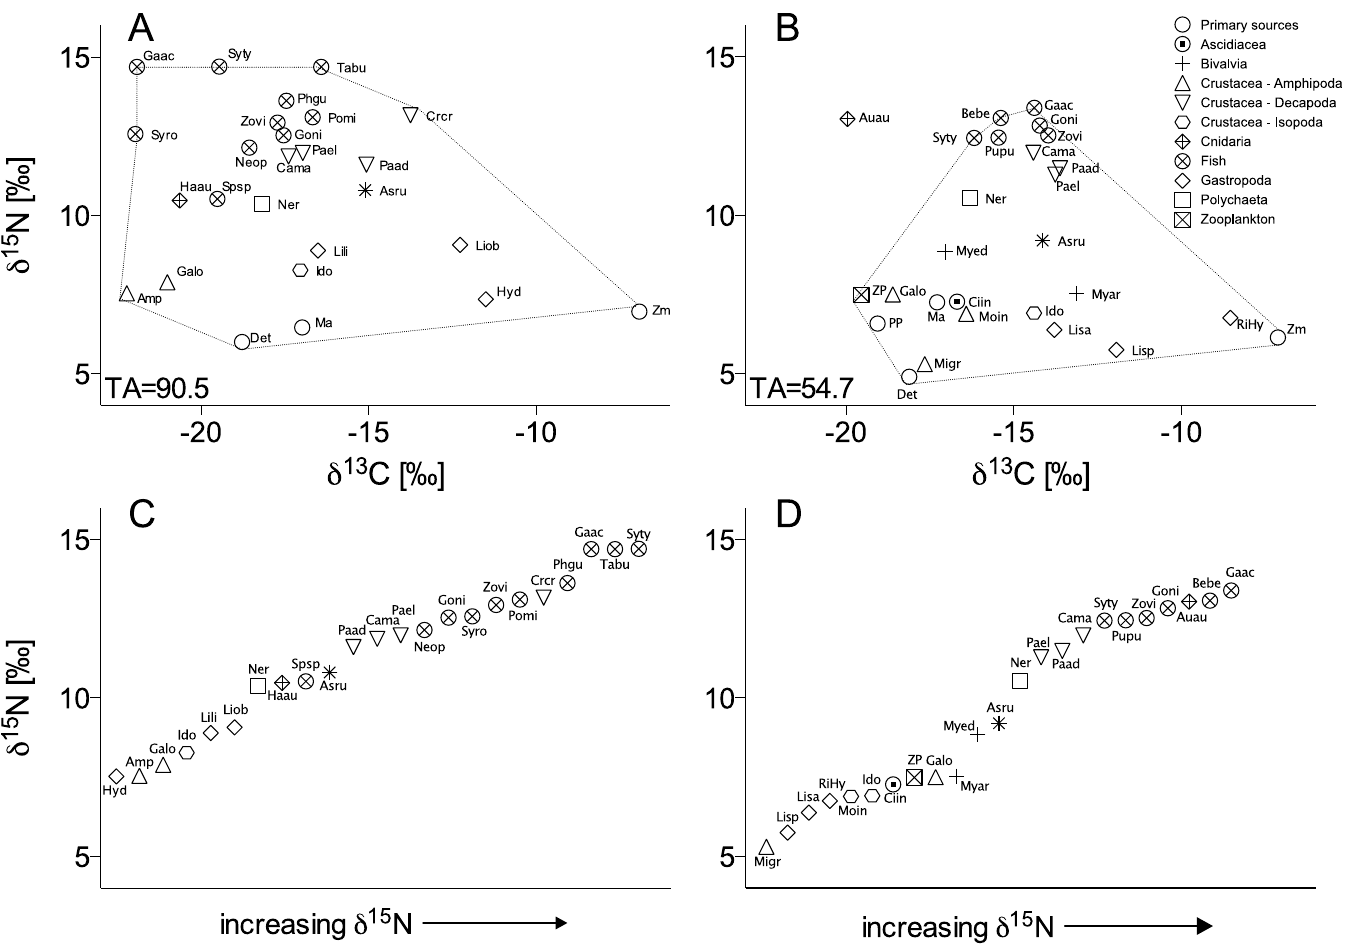
Fig 5. Stable isotope values of species associated to Zostera marina meadows in Dalby Bay (DB) and Kertinge Nor (KN) in Denmark, June 2011. Mean δ 13 C vs. δ 15 N in (A) DB and (B) KN. Ascending mean δ 15 N values of consumer species in (C) DB and (D) KN. The dashed line indicates the convex hull. TA is the total area of the convex hull. A . aurita was excluded from the TA due its special position in the food web and lack of sampling in DB; See Table 3 for species abbreviations and isotopic